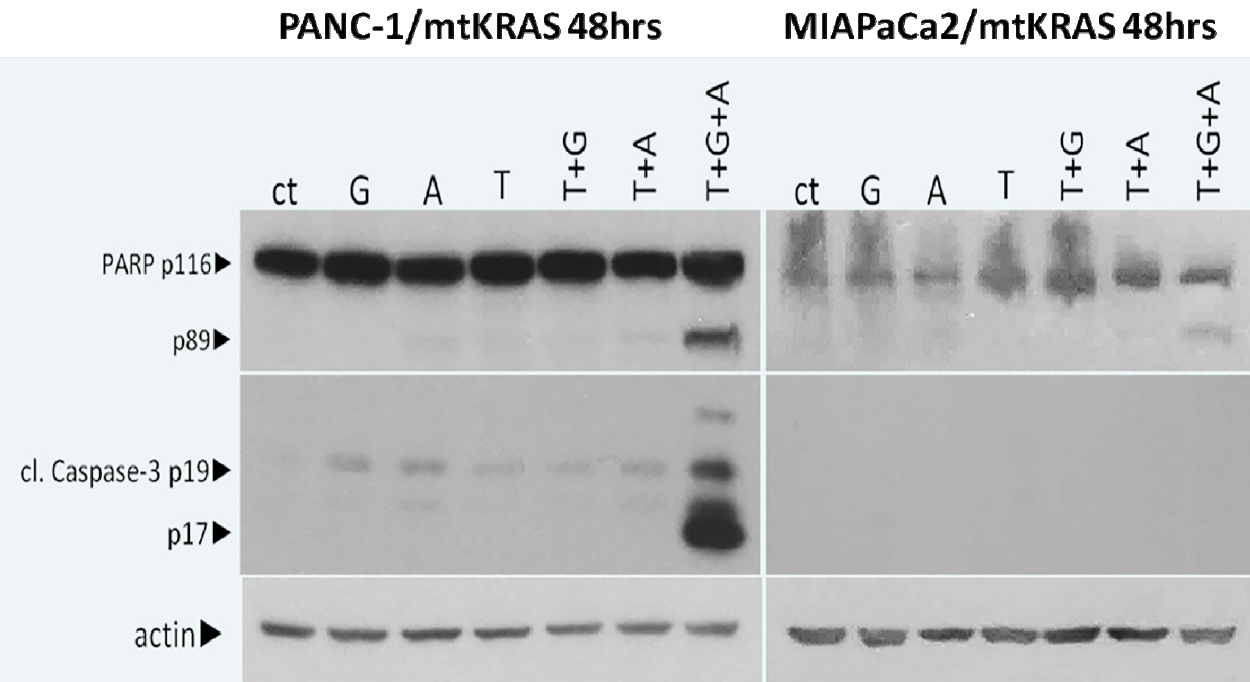
Figure 2. Tinzaparin administration with drug combinations leads to an additional increase of apoptosis. Western blot analysis of pancreatic cancer cell lines PANC-1 and MIAPaCa-2 after 48 h treatment with 1 μ M nab-paclitaxel (Nab-P), 1 μ M gemcitabine (G) and 2 UI/mL tinzaparin (T) alone or in combination. Protein levels of apoptotic cell death were identified by antibodies against PARP and cleaved caspase-3. Protein levels were normalized against actin. A representative image of two replicates is shown.